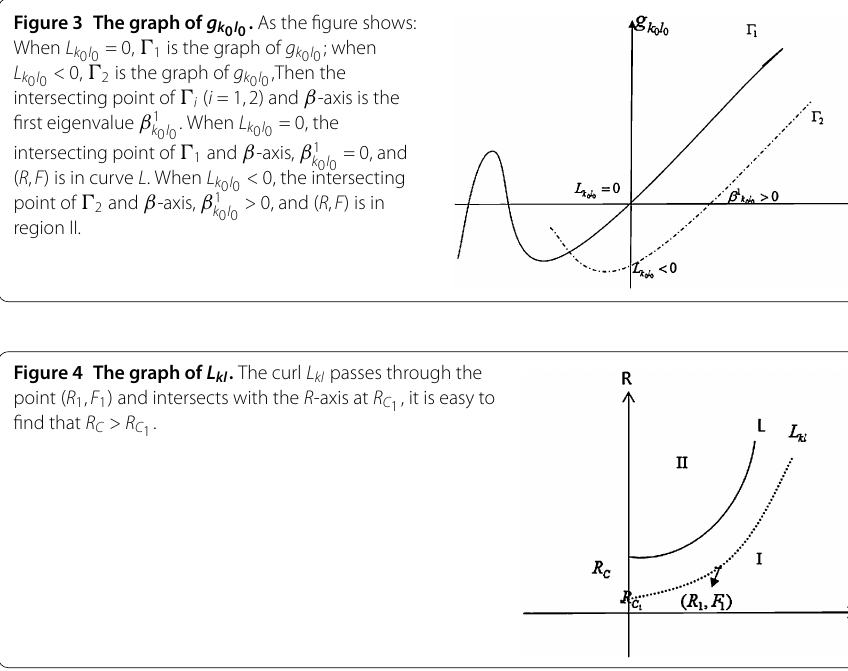
Figure 3 The graph of g k . As the figure shows: 0 l 0 = 0, (cid:16) 1 is the graph of g k ; when When L k 0 l 0 0 l 0 L k < 0, (cid:16) 2 is the graph of g k ,Then the 0 l 0 0 l 0 intersecting point of (cid:16) i ( i = 1,2) and β -axis is the first eigenvalue β 1 . When L k = 0, the k 0 l 0 0 l 0